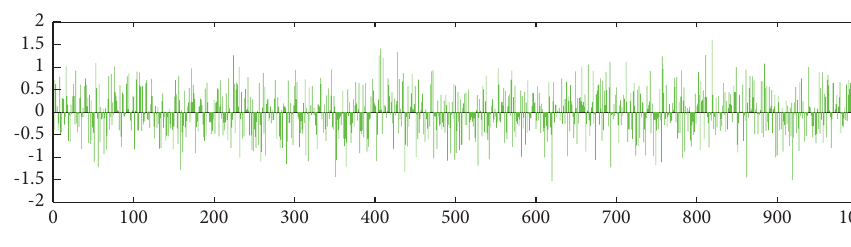
Figure 8: Initial signals u